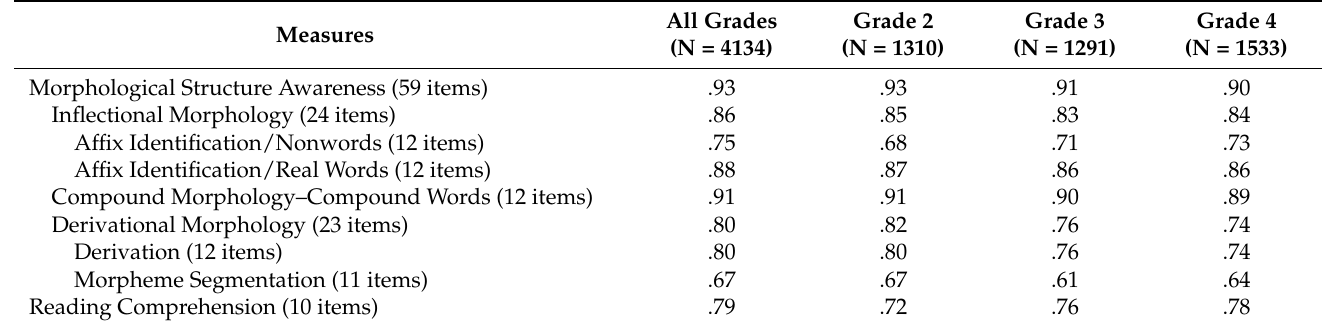
Table 3. The reliabilities of the instrument (Cronbach’s